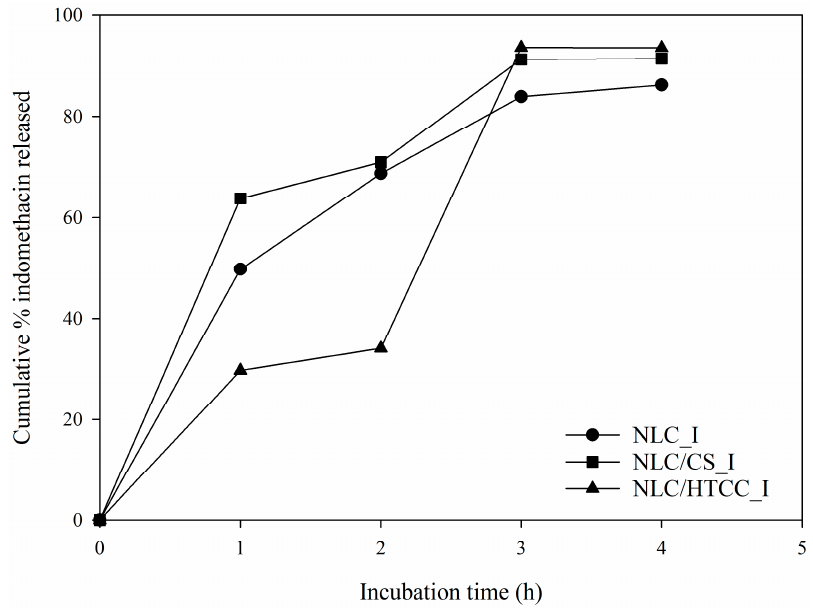
Figure 7. In vitro digestion characteristics of three different indomethacin loaded NLC formulations. NLC_I, indomethacin loaded NLC formulation; NLC/CS_I: indomethacin loaded NLC formulation